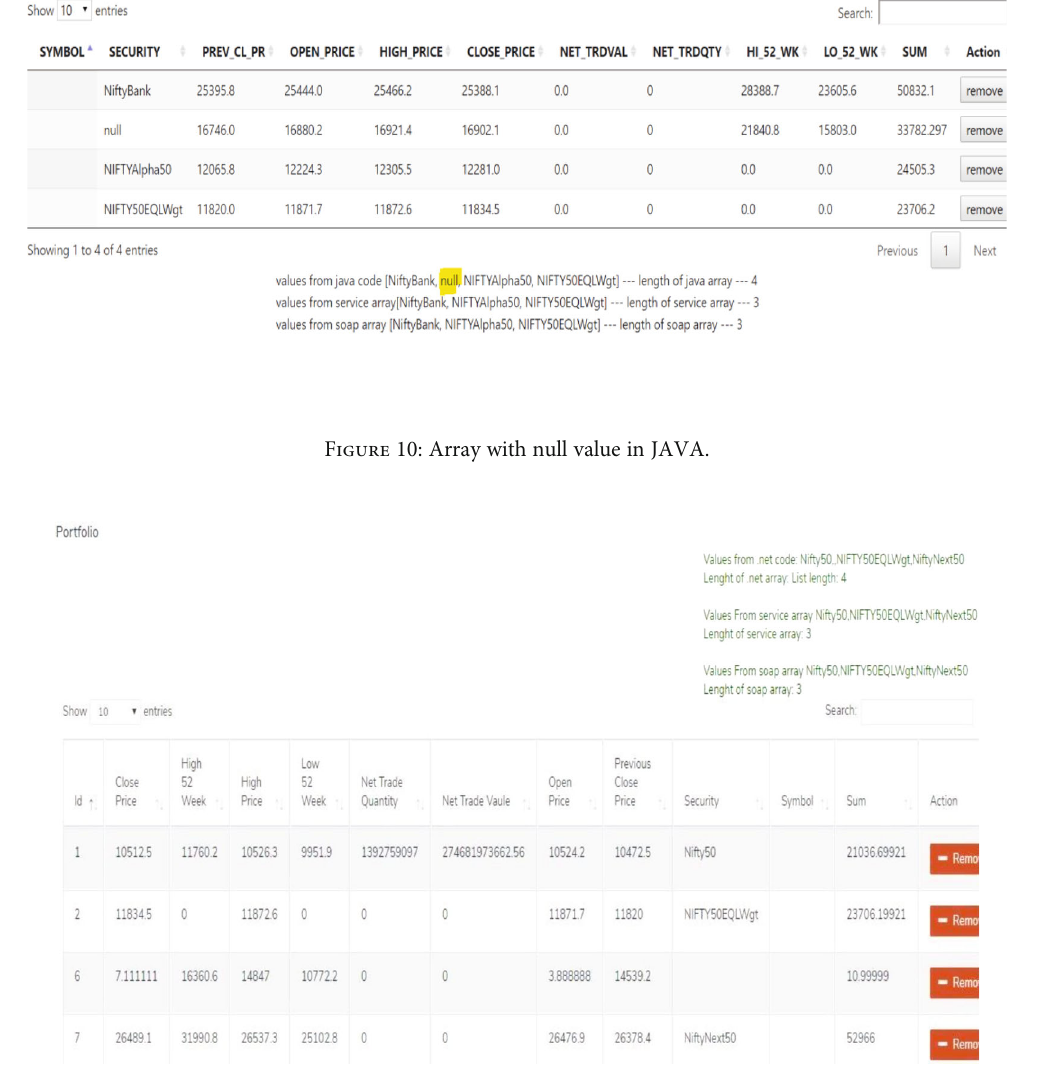
Figure 11: Array with null value issue in .NET.